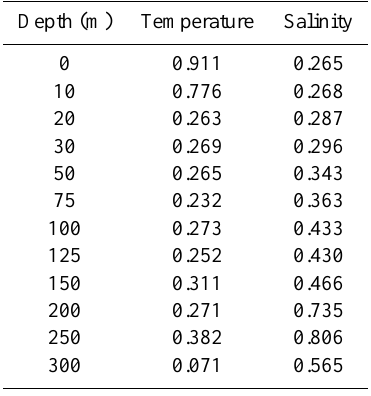
Table 3. Total effective coverage rate at standard Levitus levels down to 300m for temperature and salinity.